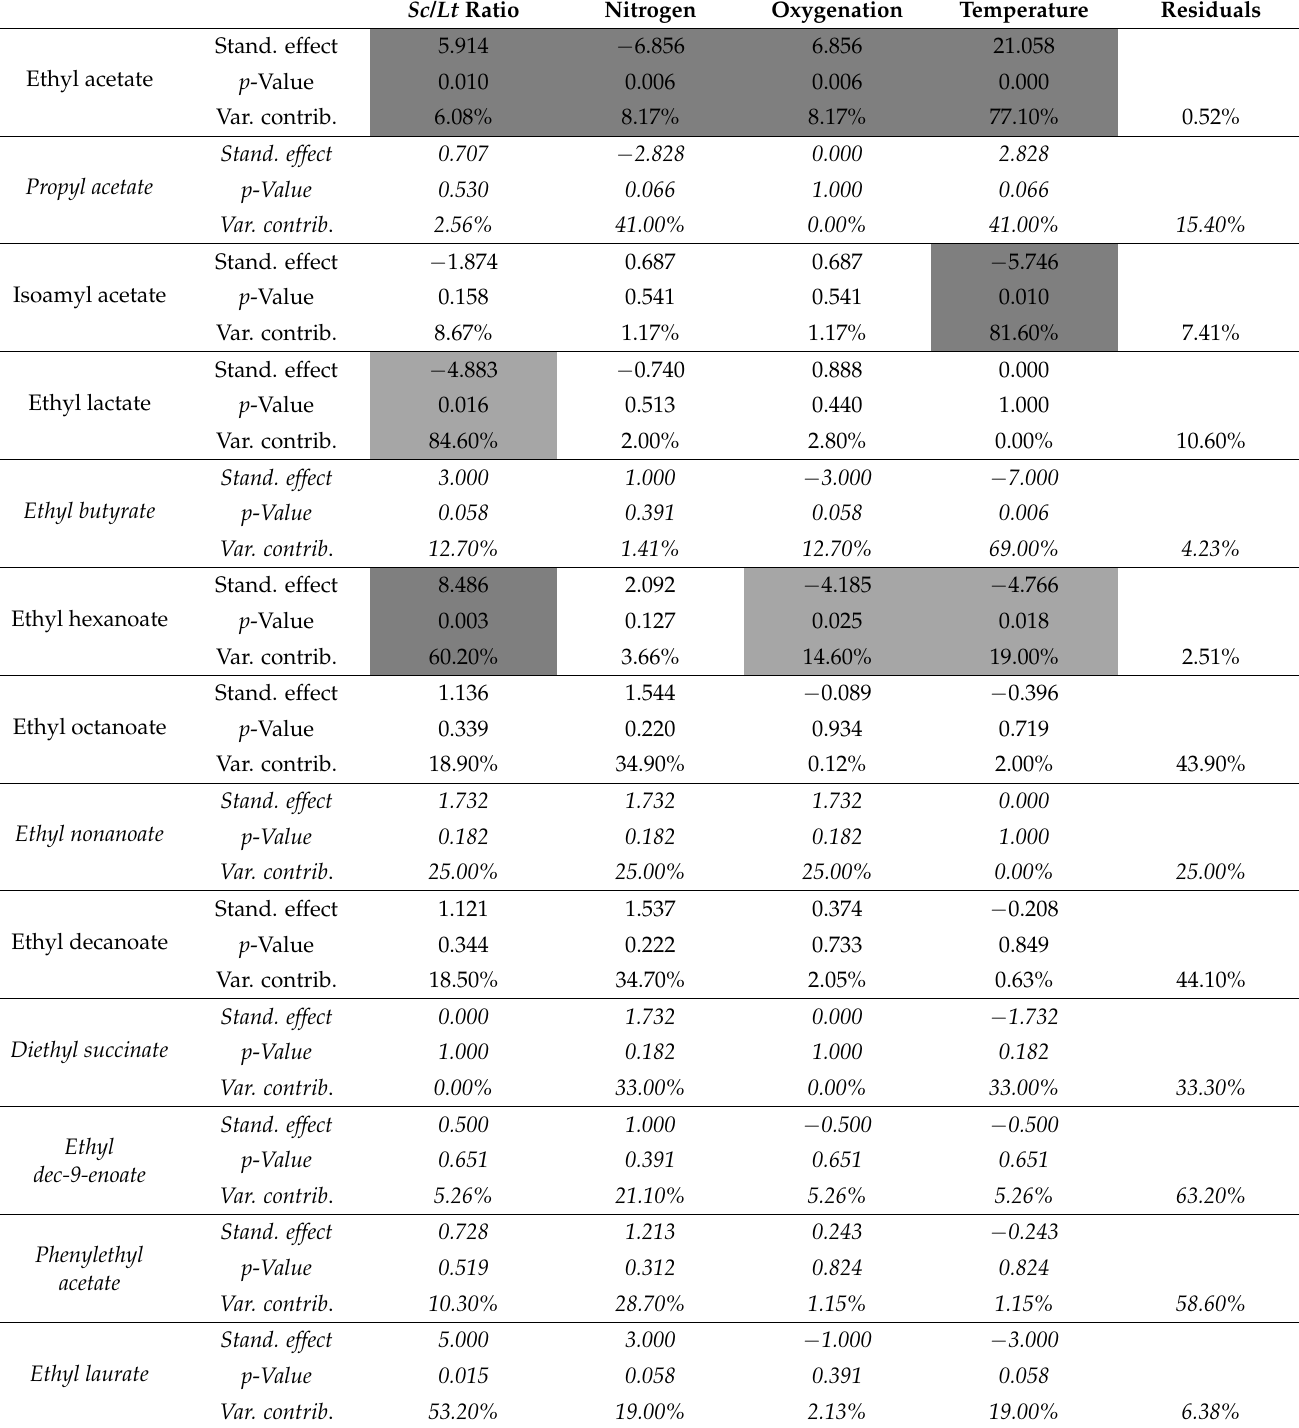
Table 8. Impact of fermentation parameters on the production of different esters. Sc / Lt Ratio Nitrogen Oxygenation